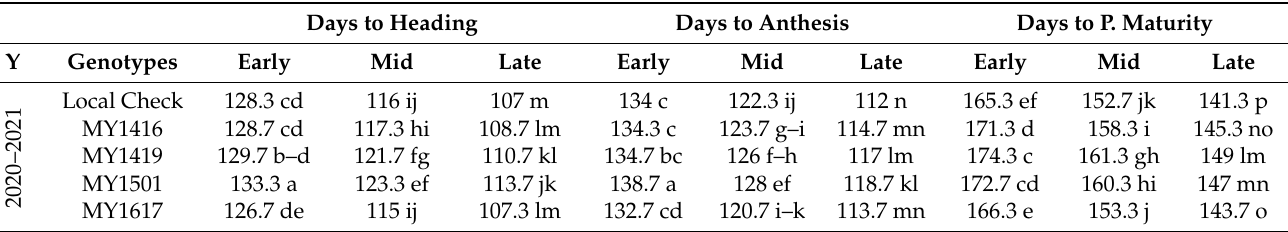
Table 3. Days to heading, days to anthesis, and days to physiological maturity of different wheat genotypes grown under the semi-arid climate of northern Pakistan. Days to Heading Days to Anthesis Days to P.